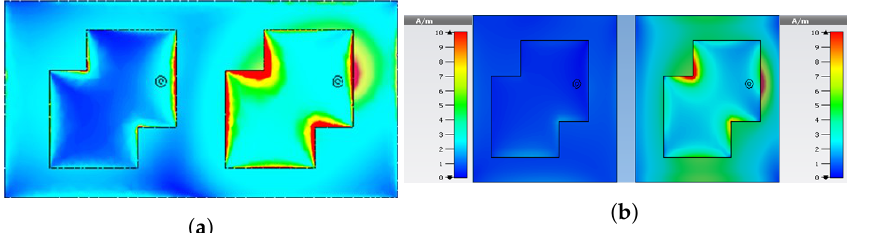
Figure 5. ( a ) Simulated surface current distribution without ground slot; ( b ) simulated surface current distribution with ground slot.